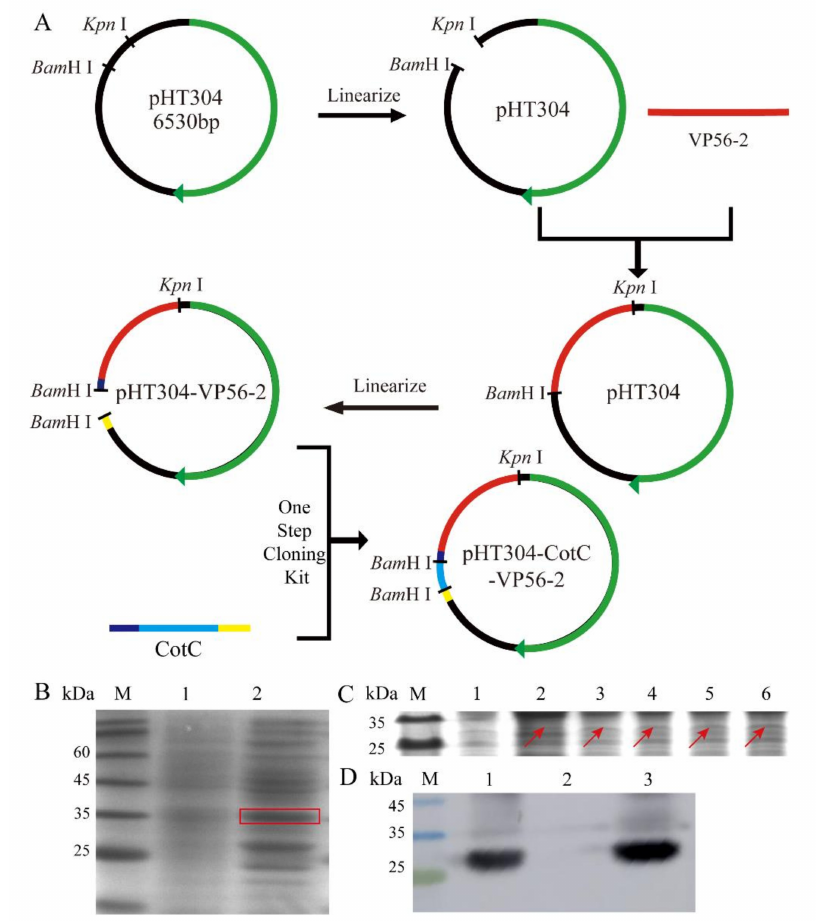
Figure 2. Construction and expression of the pHT304-CotC-VP56-2 recombinant plasmid. ( A ) Schematic diagram of pHT304-CotC-VP56-2 recombinant plasmid construction. ( B ) The recombinant plasmid was expressed in B. subtilis WB600. Lane M: protein marker, Lane 1: CotC spores, Lane 2: 48